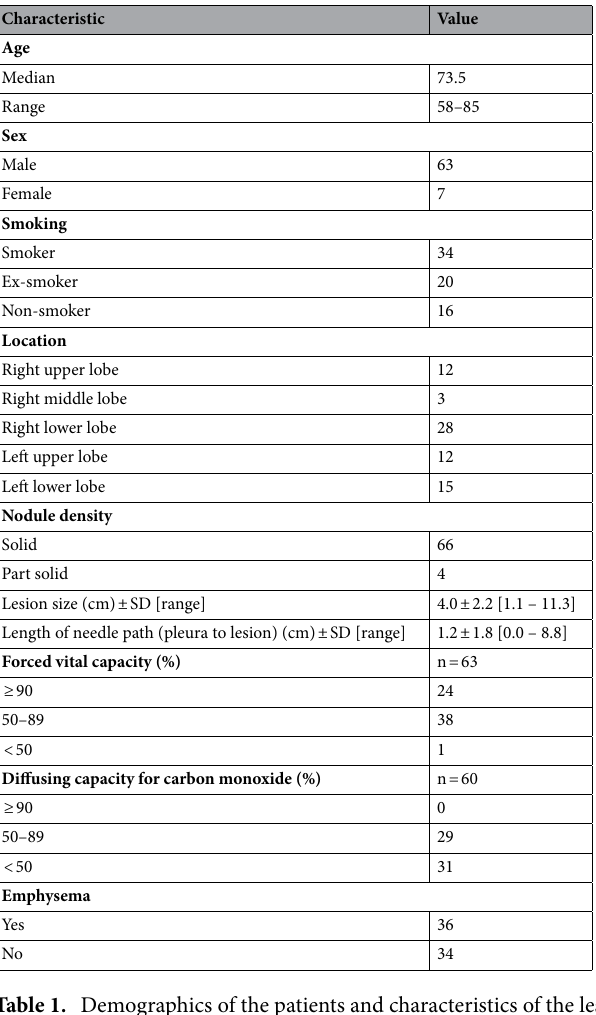
Table 1. Demographics of the patients and characteristics of the lesions; SD standard deviation.